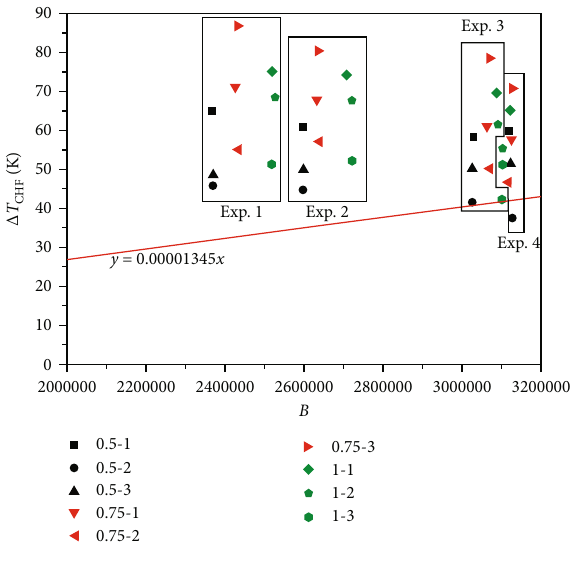
Figure 20: Experimental Δ T 0.045